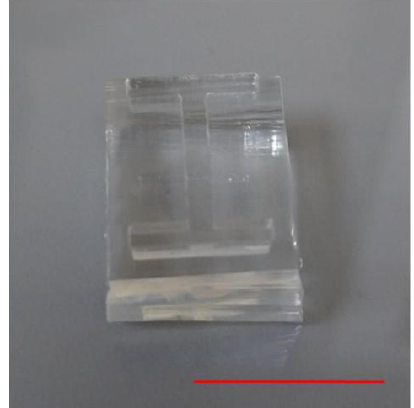
Figure 1. Picture of the customized PDMS I-shaped barrier. Scale bar = 1.5 cm.